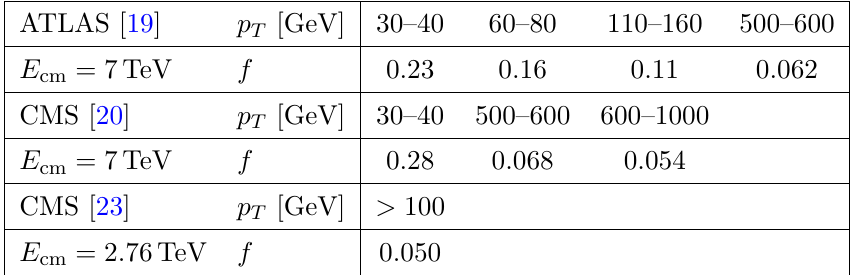
Table 3 . Fitted values for the parameter f of the nonperturbative \model 2", for the jet transverse momentum intervals of the ATLAS [19] and CMS [20, 23] data that we show here. Note that the jet radius R and the rapidity intervals (cid:17) di(cid:11)er between the di(cid:11)erent data